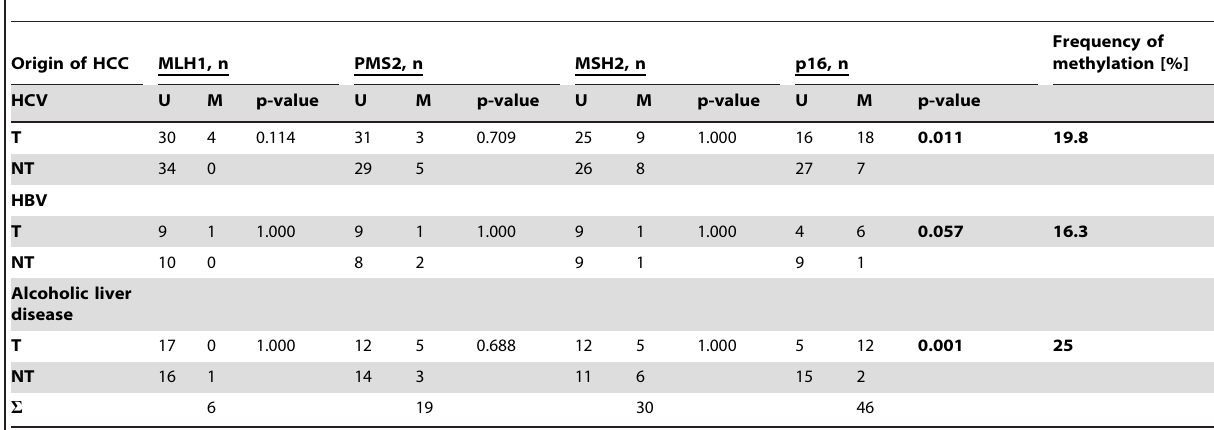
Table 3. Frequency of promoter methylation.